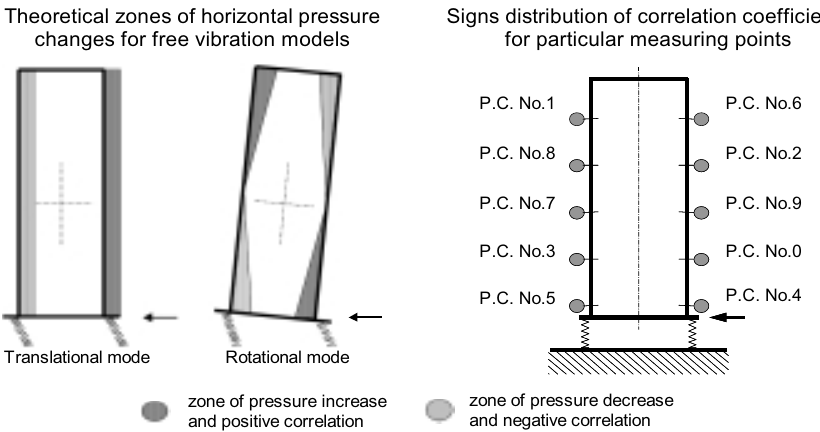
Fig. 8. Dependence of pressure change from displacement direction of silo wall and correlation of model base displacements and horizontal pressures.